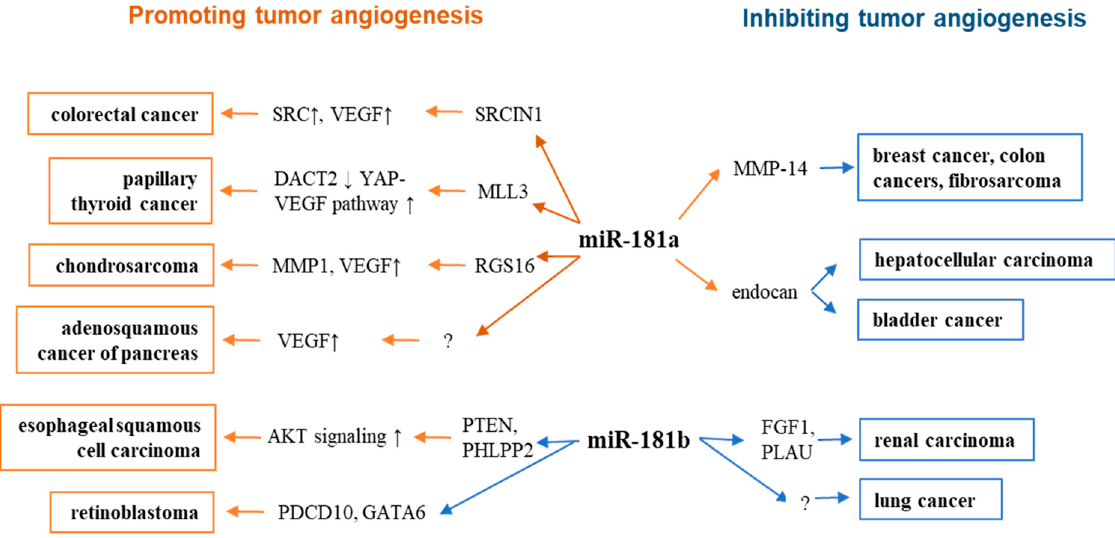
Figure 2. Role of miR-181 family members in angiogenesis of different types of cancer.